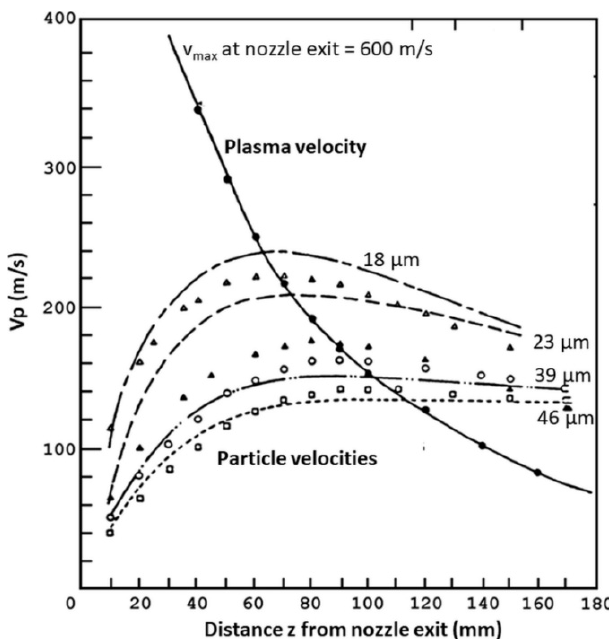
Figure 2. Transfer of plasma velocity (solid line) to alumina particles of different sizes (18–45 µm; dashed and dotted lines) suspended in an Ar/H 2 plasma [5]. © With permission by Wiley-VCH, Weinheim, Germany.